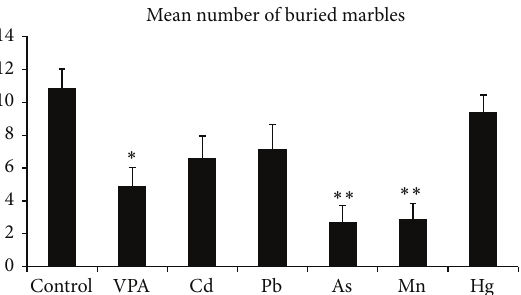
Figure 2: Marble-burying test for perseverative/repetitive behavior: VPA, As, and Mn exposed animals bury significantly fewer marbles than controls. Data were analyzed using the nonparametric ANOVA (Kruskal-Wallis test) with Dunn’s multiple comparison test. ∗ denotes statistical significance ( 𝑝 < 0.05 ); ∗∗ denotes statistical significance ( 𝑝 < 0.001 ).